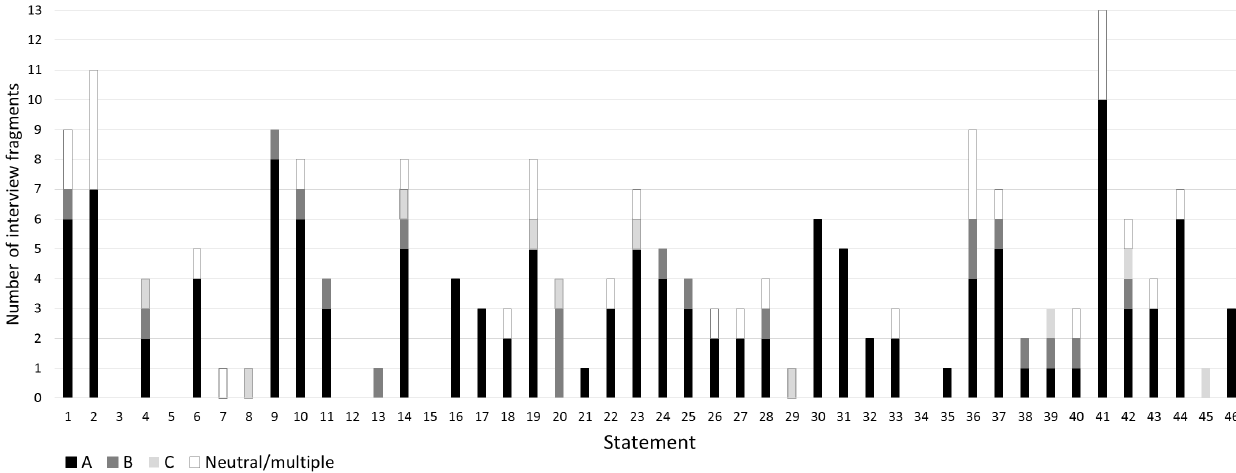
Figure 4. Distribution of interview fragments available per viewpoint and per statement. Interview fragments of people that load to no or two viewpoints were categorized as